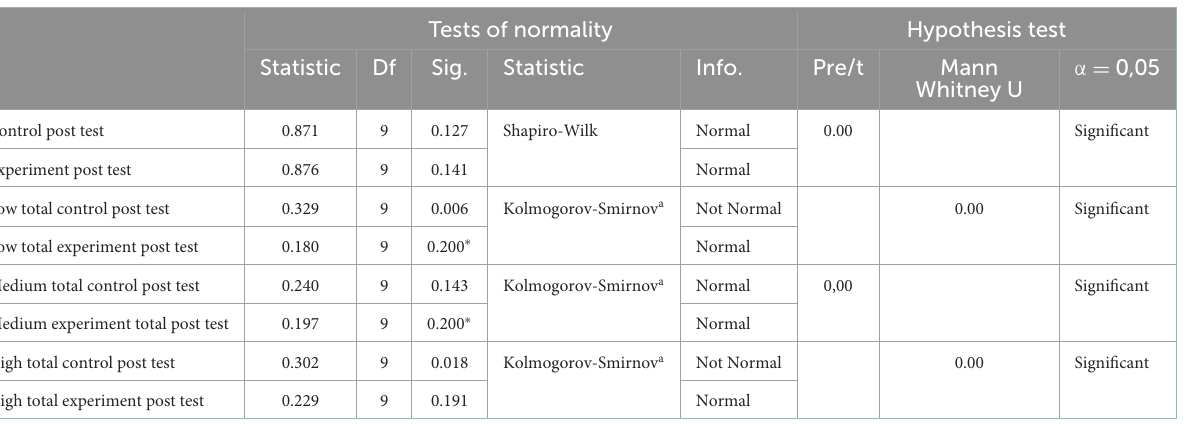
TABLE 4 General differences in student critical thinking